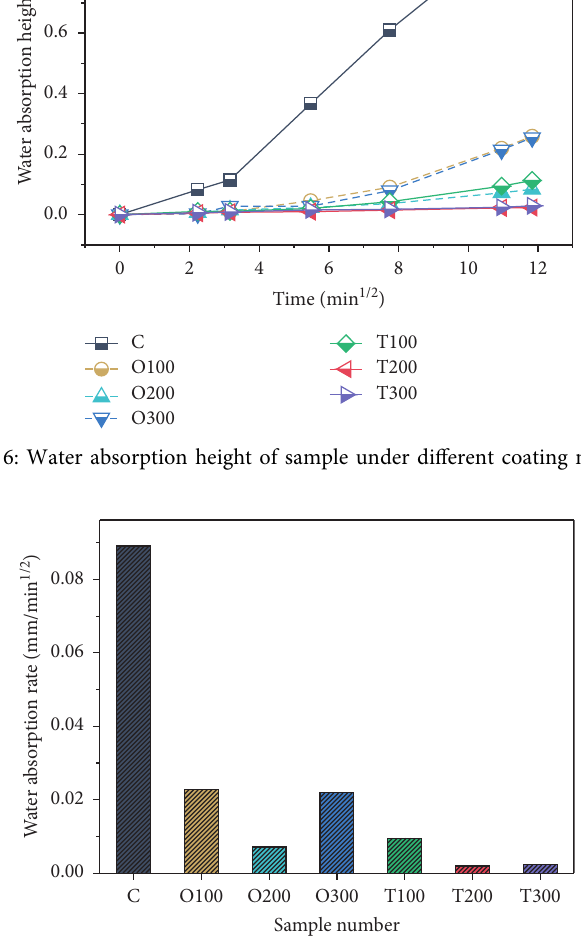
Figure 7: Water absorption rate of samples under different coating methods.